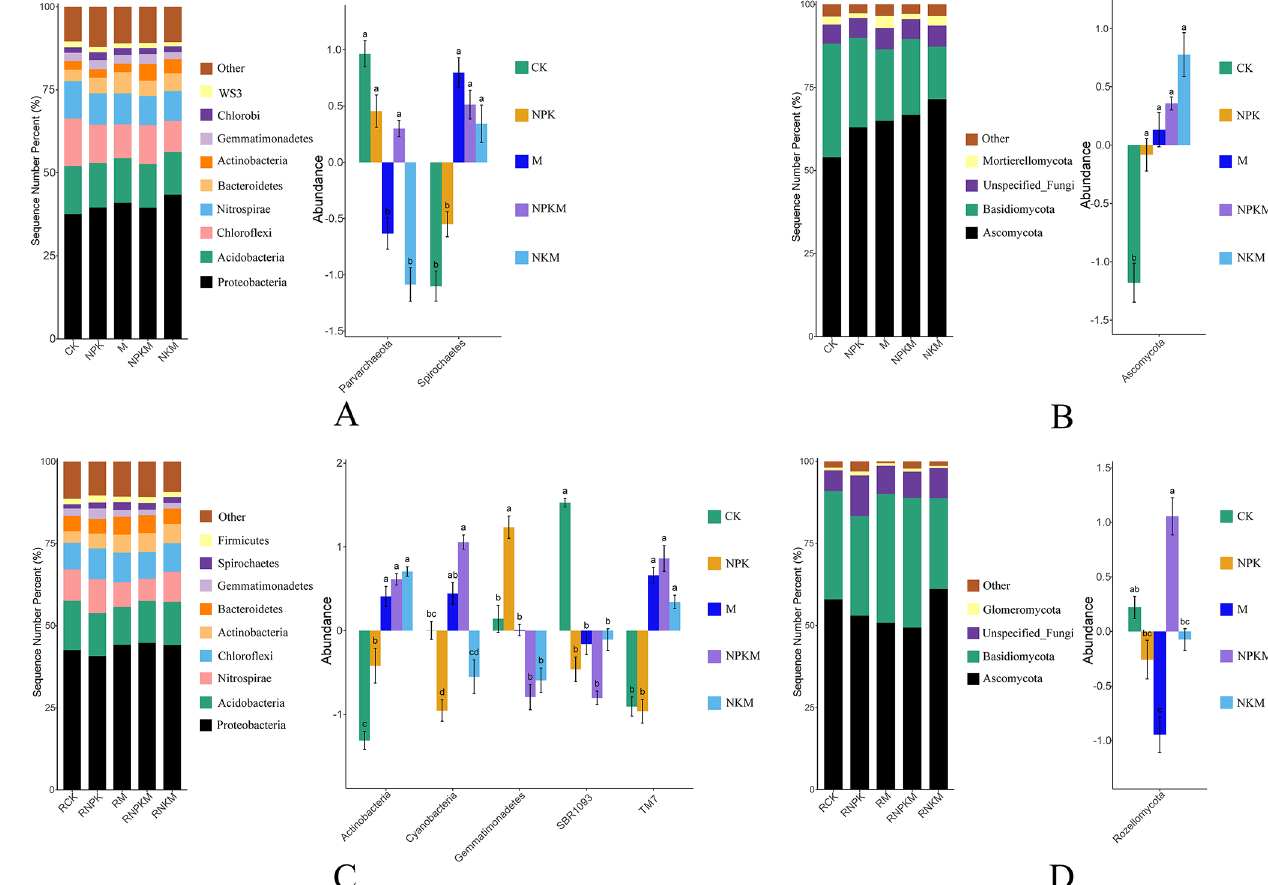
Figure 2. The microbial relative abundance (left) and the features with significant differences (Anova + Duncan; p < 0 . 05; n = 6) between groups (right) at the phylum level in five treatments (CK, NPK, M, NPKM, and NKM). Capital letters shown with the bar graphs refer to different classifications ( A – bacteria in bulk soil; B – fungi in bulk soil; C – bacteria in rhizosphere soil; D – fungi in rhizosphere